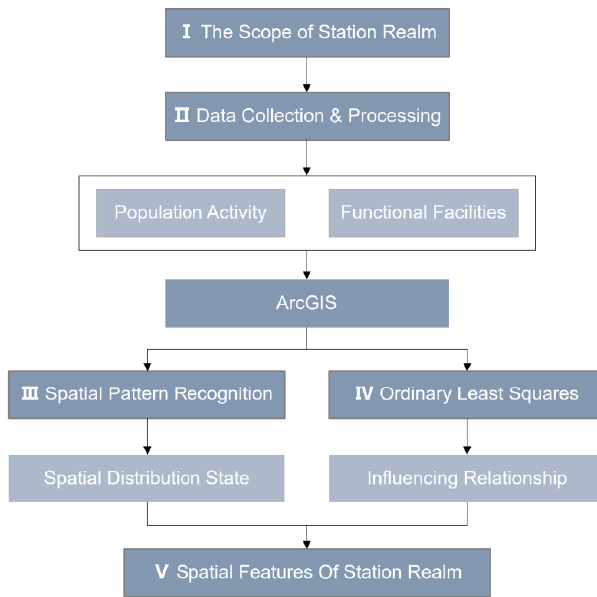
Figure 3. The framework of the research